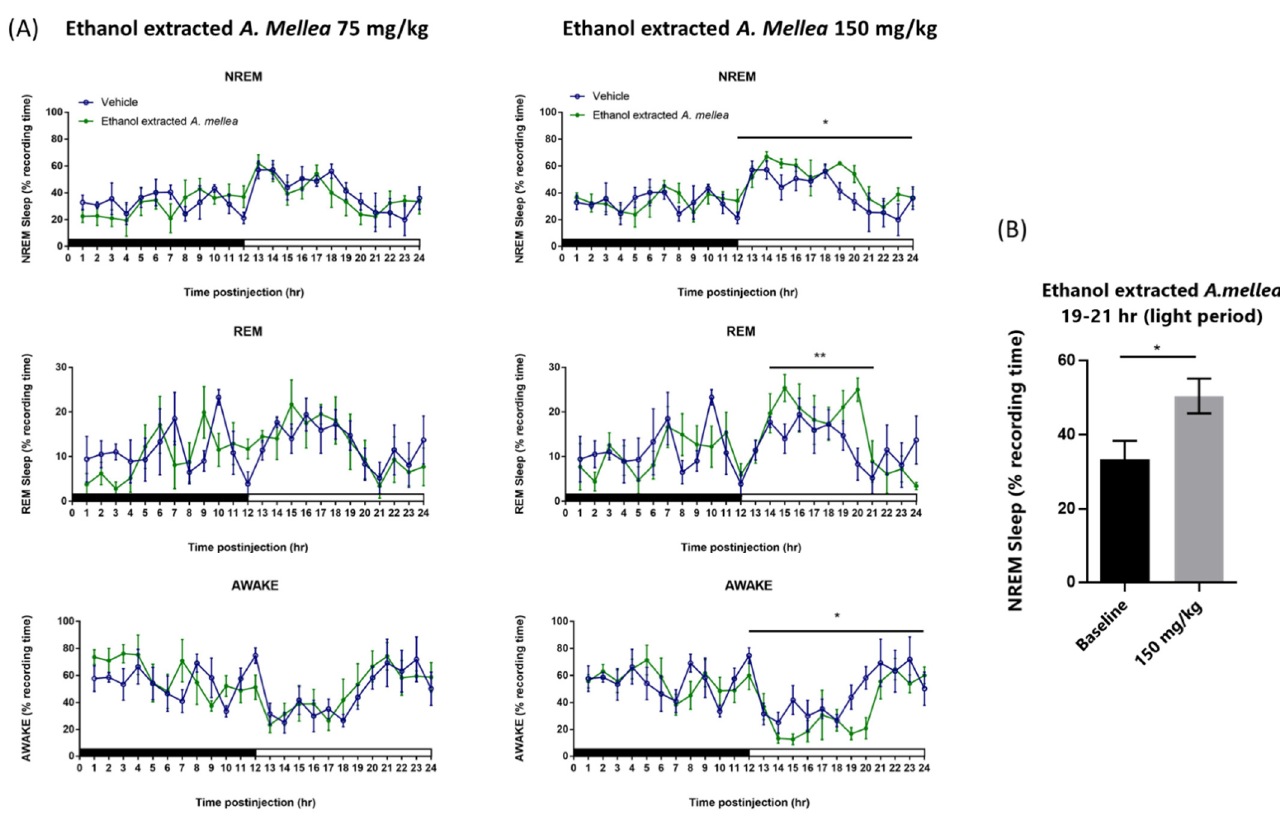
Figure 2. Ethanol extracted A. Mellea increased NREM and REM in rats. ( A ) Time-course changes and ( B ) total amounts of REM, NREM sleep and awake produced after oral administration of ethanol extracted A. Mellea at 75 mg/kg and 150 mg/kg. Open and closed circles stand for the profiles of vehicle and A. Mellea treatments, respectively. The x -axes indicate the 12 h dark (the black bar) and 12 h light periods (the white bar). Values are means ± SEM ( n = 6). * p < 0.05 and ** p < 0.01 indicate significant differences compared with the vehicle group.